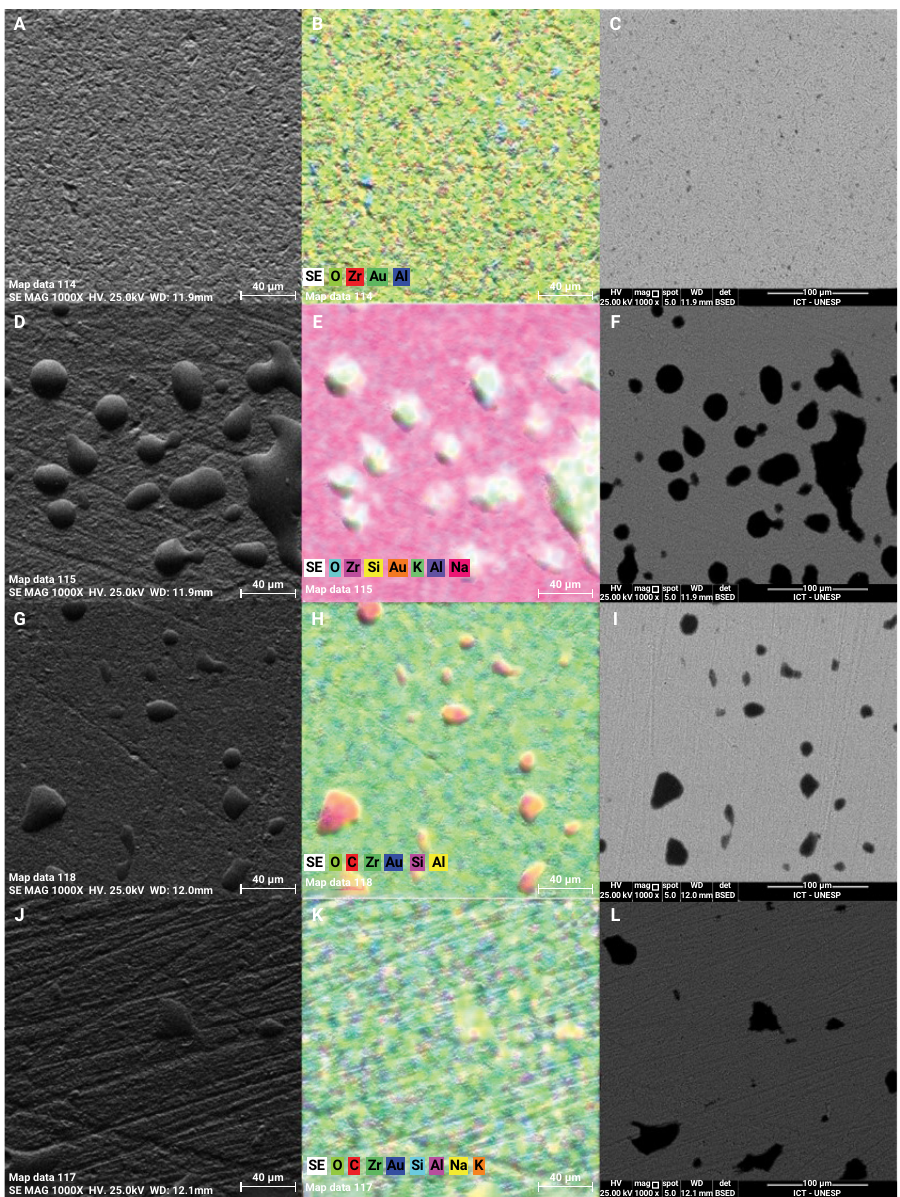
Figure 2. SEM, mapping and BSE (1000X) of the control group RS (A,B,C), showing homogenous surface; and the experimental GS20s (D,E,F), GS60s (G,H,I) and GS100s (J,K,L), which reinforce the irregular distribution of the glass layer on the Y-TZP surface, forming the “glaze